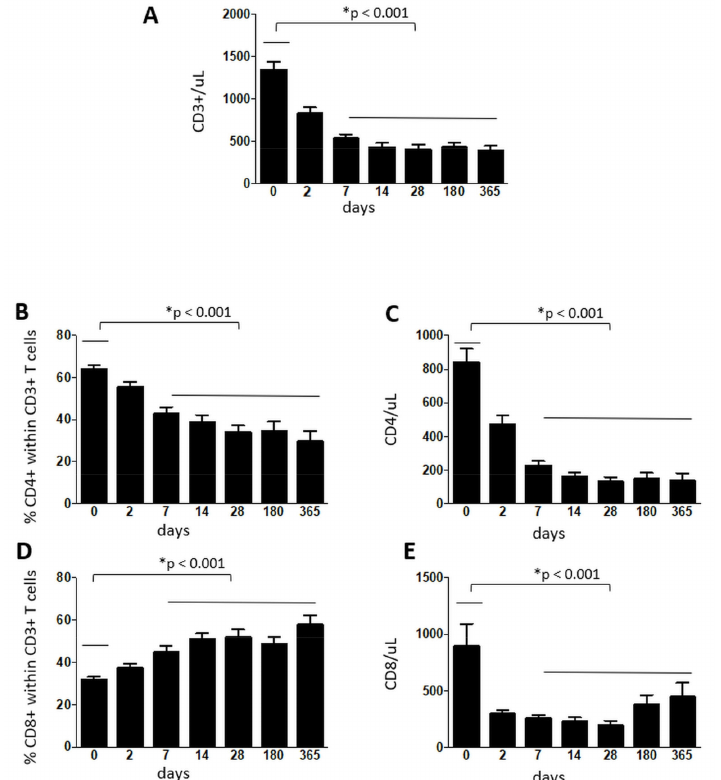
Figure 1. Absolute numbers of CD3+ cells (panel A ), percentage (panel B ) and absolute numbers (panel C ) of CD4+ cells among CD3+ cells and percentage (panel D ) and absolute numbers (panel E ) of CD8+ cells among CD3+ cells derived from MS patients before starting fingolimod (0) and at different time-points throughout one year. Data are represented as mean ± standard error of the mean. N = 36 patients throughout days 0–28, N = 28 at 180 days and N = 20 at 365